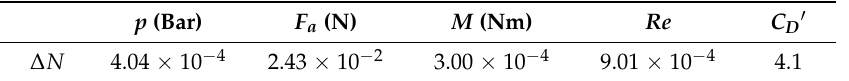
Table 2. Uncertainty analysis for the